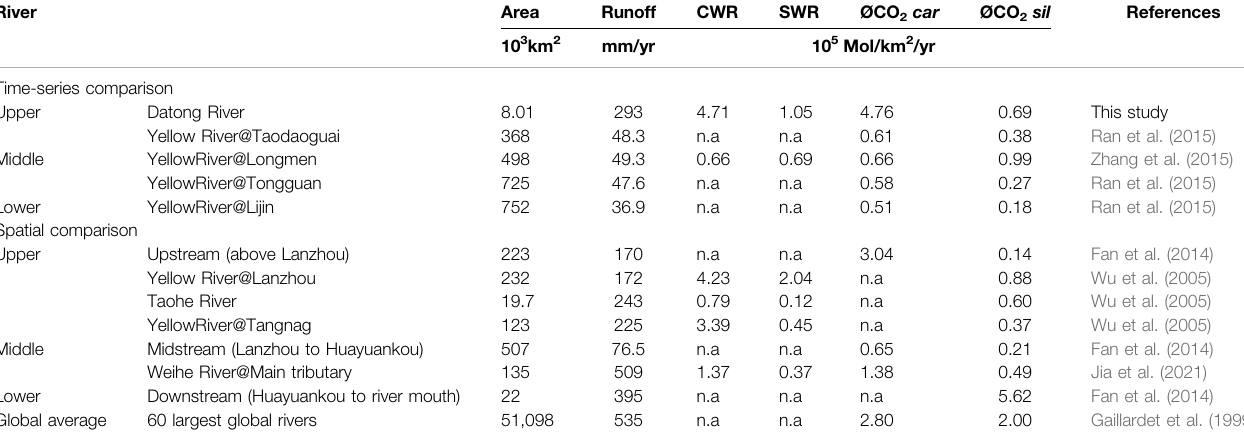
TABLE 4 | Chemical weathering and CO 2 consumption rates from the upper to lower reaches of the Yellow River.